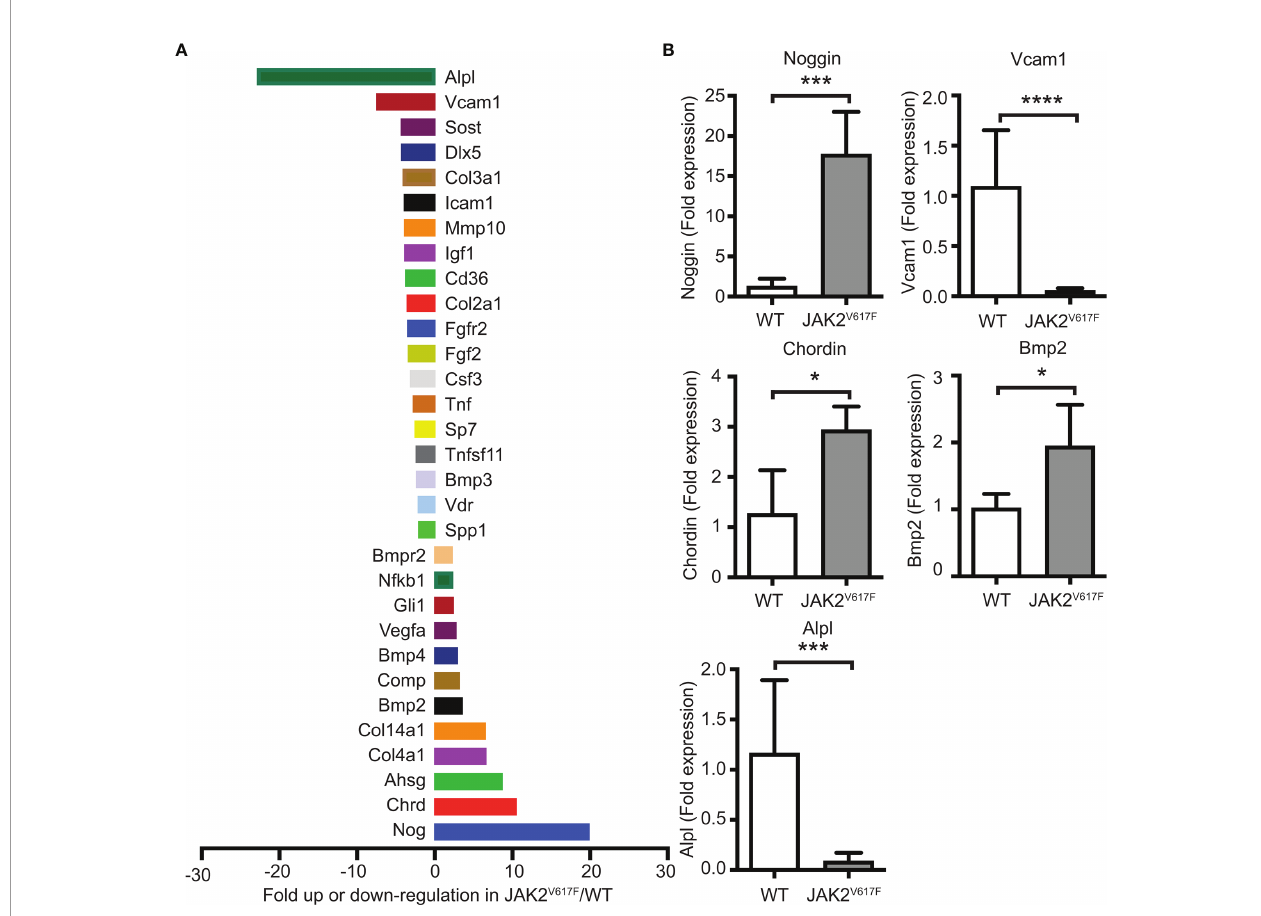
FIGURE 5 | Differential expression of bone development-related genes in MKs of JAK2 V617F mice compared to WT mice. (A) Graphical representation of more than 2-fold difference expression between JAK2 V617F and WT MKs, using the commercial RT² Pro fi ler ™ PCR Array Mouse Osteogenesis PAMM-026Z. Bone marrow cells were differentiated towards MKs as described under methods. After 4 days of culture, MKs were puri fi ed with a two-step BSA gradient and RNA-isolation and RT-PCR were performed using 1 ug of RNA. Results were normalized to b -actin, b -2 microglobulin, glyceraldehyde-3-phosphate dehydrogenase, b -glucuronidase and heat shock protein 90-alpha. Four 17 weeks old control male mice and four 17 weeks old JAK2 V617F male mice were analyzed. MKs for 2 mice were combined as one sample to obtain suf fi cient material and increase biological representation, and, thus, 2 samples were tested per category. The whole gene panel and full names of mRNA encoded genes can be found in Supplementary Table 3 . (B) Con fi rmation of mRNA results obtained with the commercial mouse osteogenesis array. Relative expression of highly displayed mRNAs in the experimental groups, including Noggin, Vcam1, Chordin, Bmp2 and Alpl in JAK2 V617F MKs, was con fi rmed using quantitative RT-PCR analysis with Taqman primers and 1 ug of RNA. Data were normalized to 18S rRNA. Four 21 weeks old JAK2 V617F mice and fi ve control male mice were individually cultured, representing one sample each. *Denotes p<0.05; ***Denotes p<0.001; ****Denotes